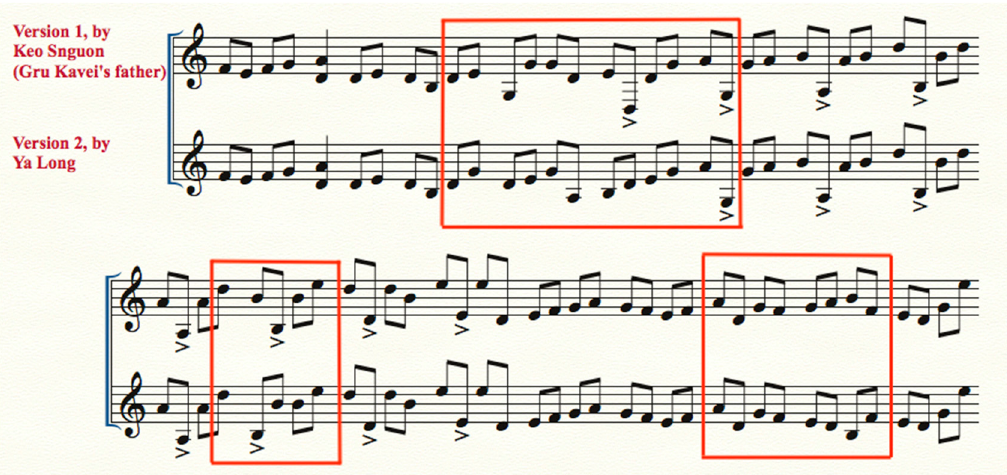
Figure 2. “S ā dhuk ā r” Variations: Two versions of a section of the song “S ā dhuk ā r”, with one of Keo Snguon’s versions notated on the top staff and one of Ya Long’s notated on the bottom, as they were taught to the author by Keo Sonan Kavei. The boxes highlight where the variations diverge.